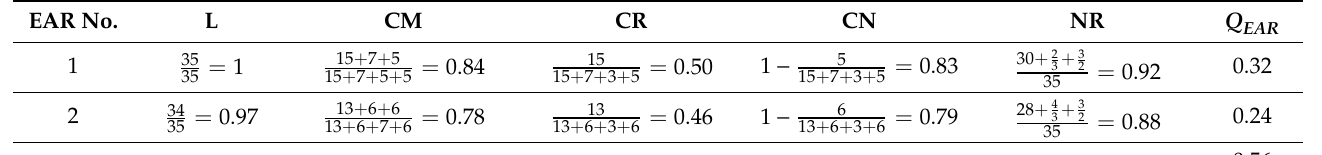
Table 2. An example of computing the quality of two academic